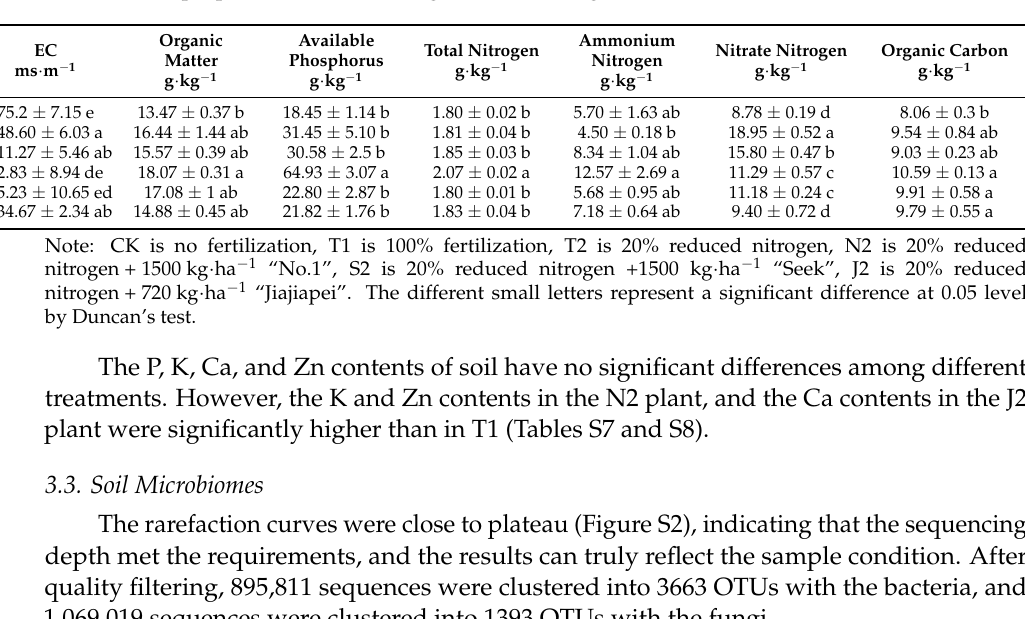
Table 2. Effects of nitrogen reduction combined with biological organic fertilizer on soil’s physical and chemical properties of non-heading Chinese